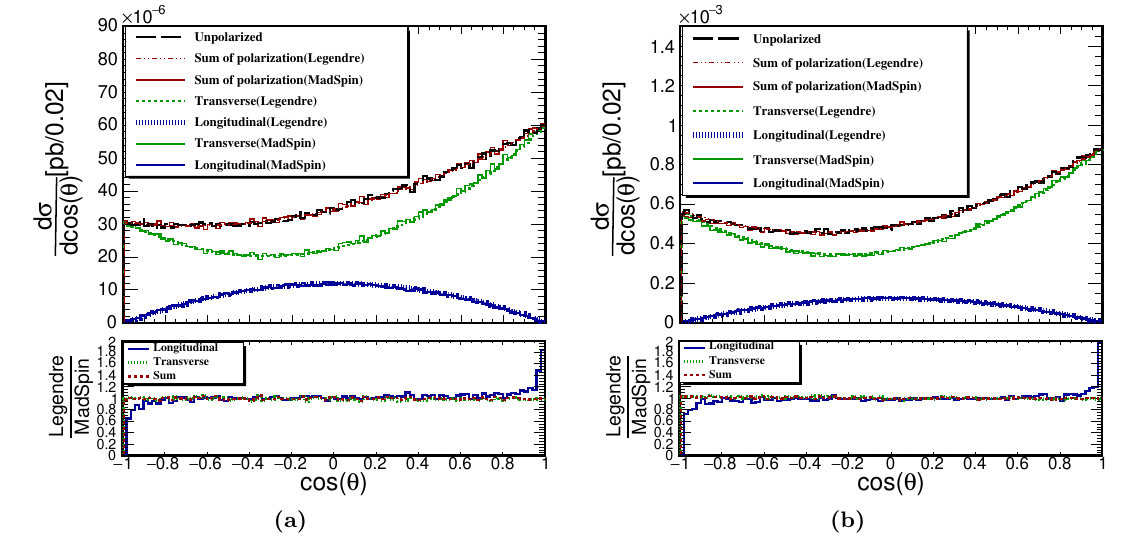
Figure 3. Same as (cid:12)gure 2(a) but for the MadSpin and the Legendre Expansion methods, assuming (a) pure EW and (b) mixed EW-QCD production of jjW + W (cid:0) at LO. Impact of selection cuts on polarized